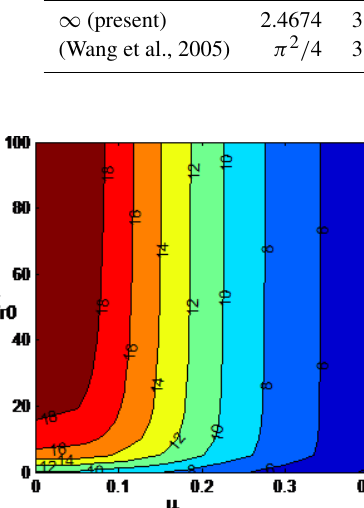
Fig. 2 for the case k r1 = 0, k t = 10 8 , i.e., the end point x = L